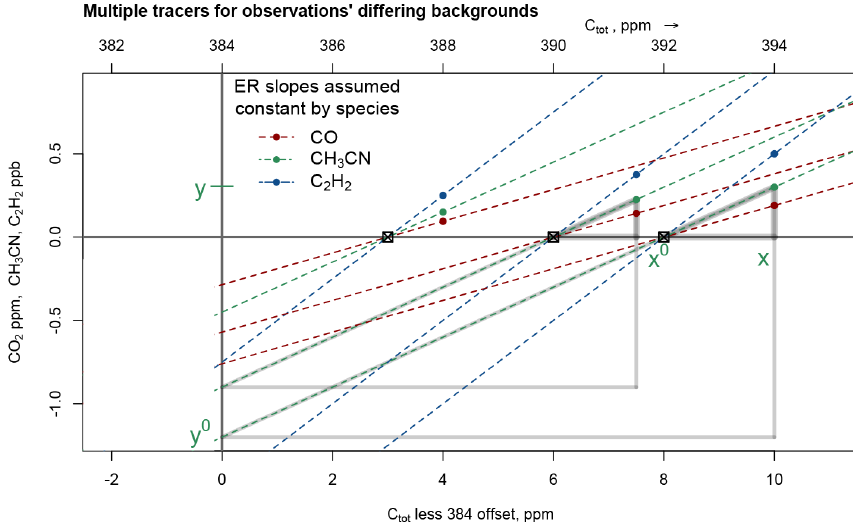
Figure 7. Multiple tracers allow a solution for an equivalent-background x 0 value, illustrated by an idealized example largely replicating the conditions of fire plume sampling above an Amazonian mixed layer as described by Yokelson et al. (2013). The dashed colored lines indicate the theoretical response of tracer to the C tot when C bkgd takes on various values indicated by black squares. There are several lines showing the ideas expressed in Fig. 6a. The fact that the various colored lines associated with each x value meet at the value with x coordinate x 0 and y coordinate 0 represents the estimation that precisely solves Eq. (5) above. If we had included error in observations or variation in EnRs, there would be variations in the positions of x 0 and the slopes. As Sect. 6.1 describes, regression of tracer vs. C tot is required and gives a spread of y intercepts. Nevertheless, these can be mapped back to x intercepts using slopes and the concept of similar triangles. The nested gray triangles illustrate this idea for each of two values of x 0